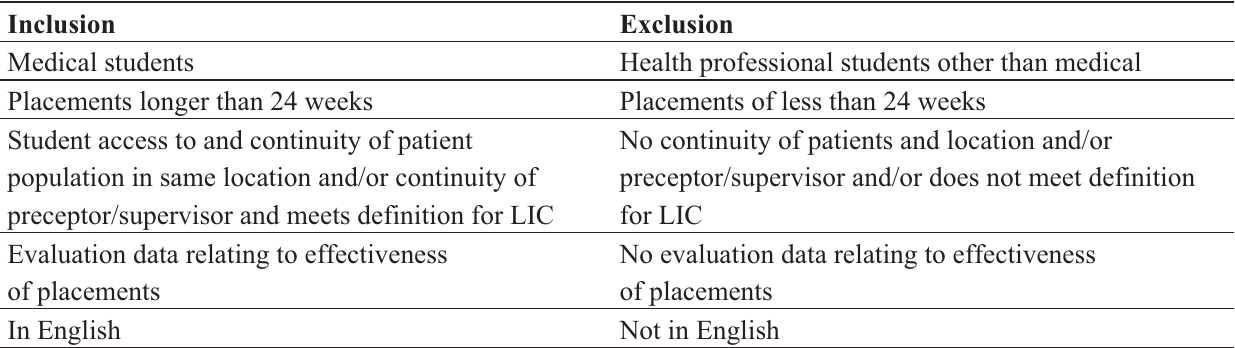
Table 1. Inclusion and Exclusion Criteria